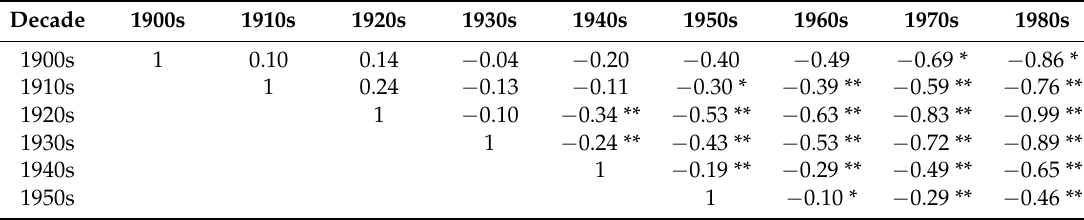
Table 4. Mean differences of age at menarche among different decades of